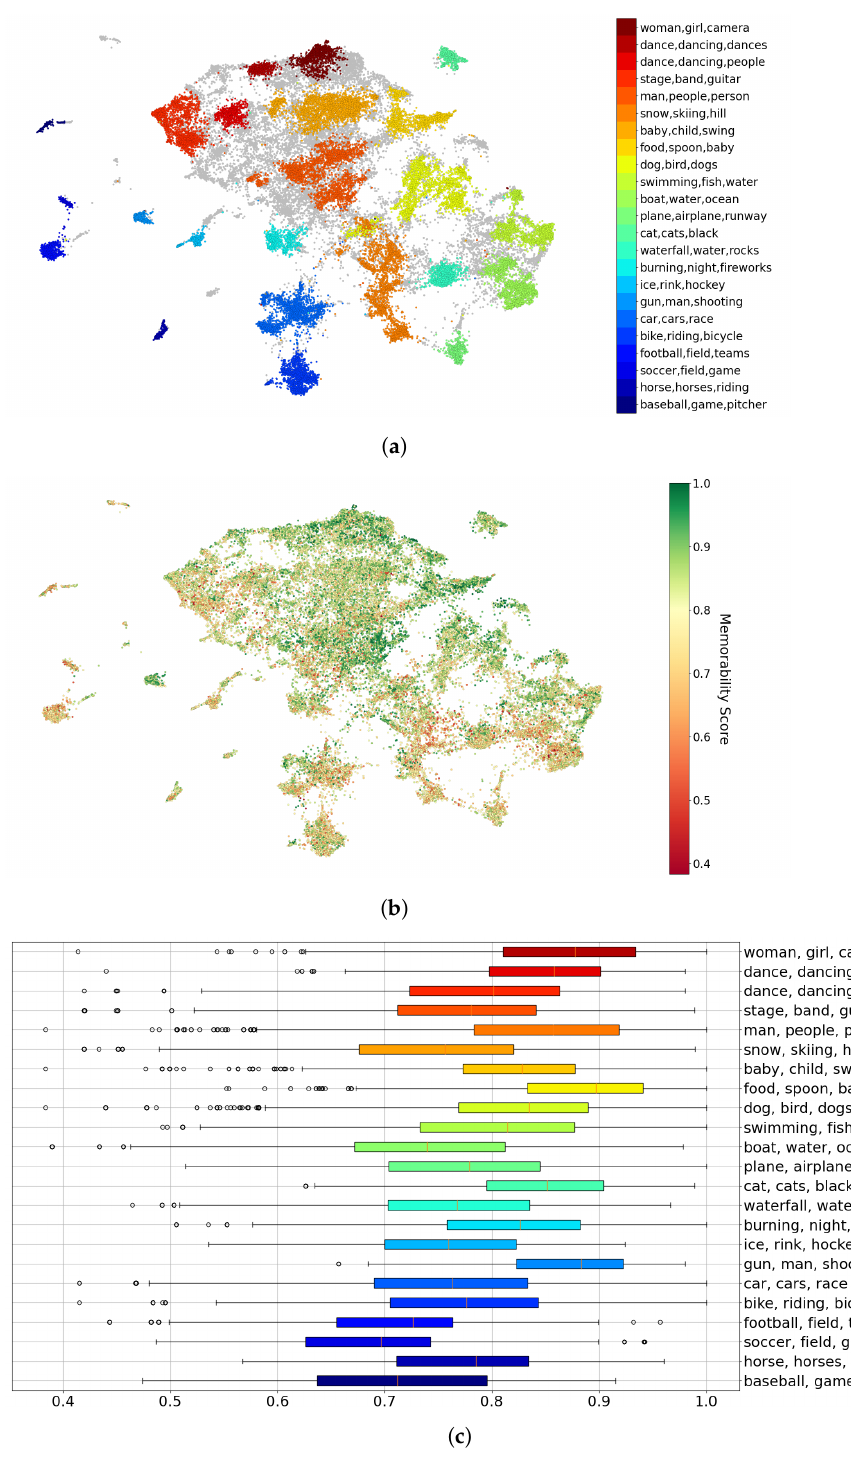
Figure 6. Automatic topic discovery from Sentence-BERT vector embeddings in the Memento10K dataset under a late AVG strategy. A finer degree of detail can be found here about the content of the topics. ( a ) Memento10K’s topics detected from a late AVG scheme. ( b ) Samples shown in color according to their memorability score. ( c ) Distribution of memorability scores within each detected